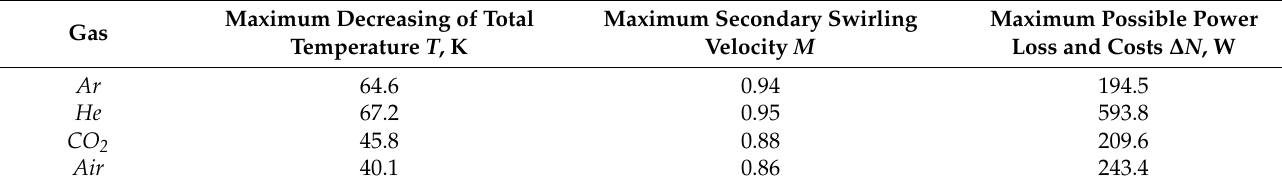
Table 7. SVT efficiency with the same